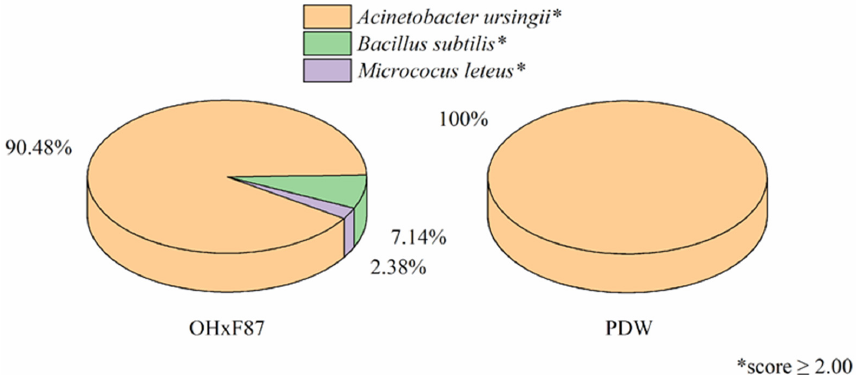
Figure 2. Microbial community isolated from in vitro plants of Pyrus communis and identified using MALDI-TOF MS.